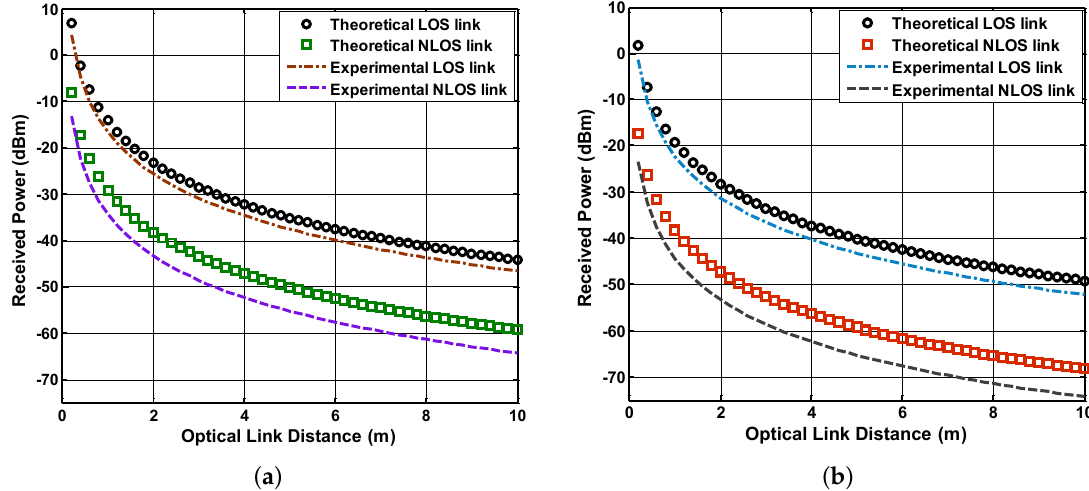
Figure 11. Received power analysis between LOS and NLOS VLC links. ( a ) Received power in mine gallery. ( b ) Received power in